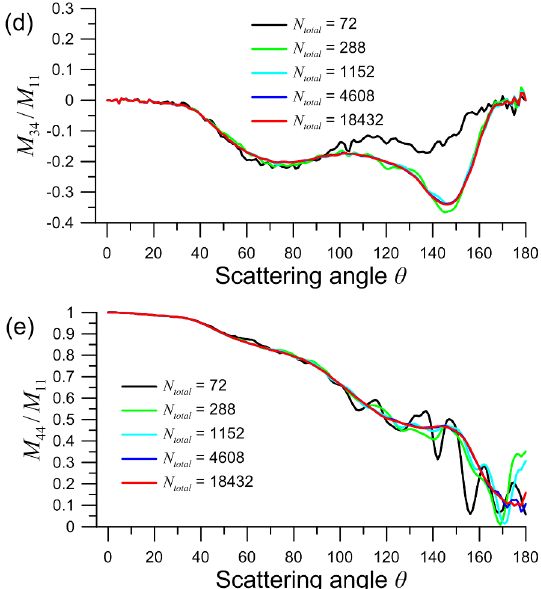
Figure 2. The same as in Fig. 1 for other elements of the Mueller